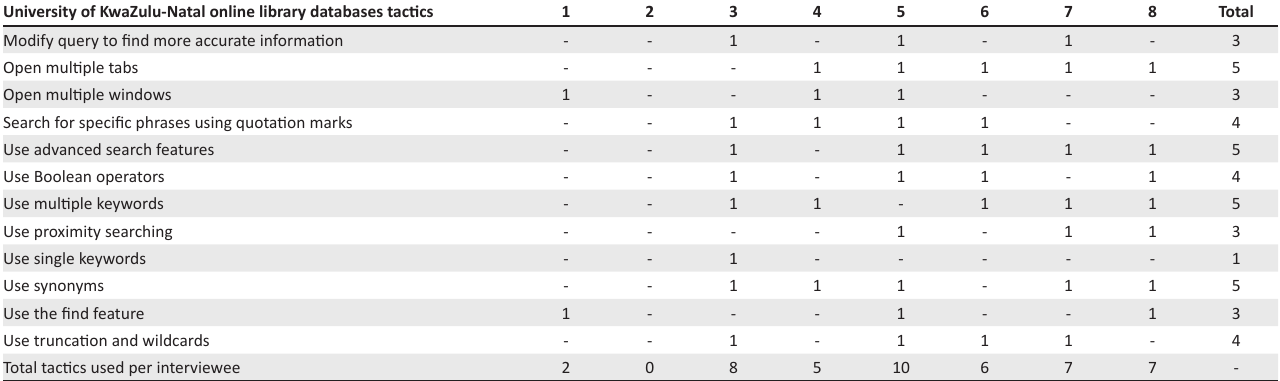
TABLE 6: Web search strategies using the University of KwaZulu-Natal online library databases. University of KwaZulu-Natal online library databases tactics